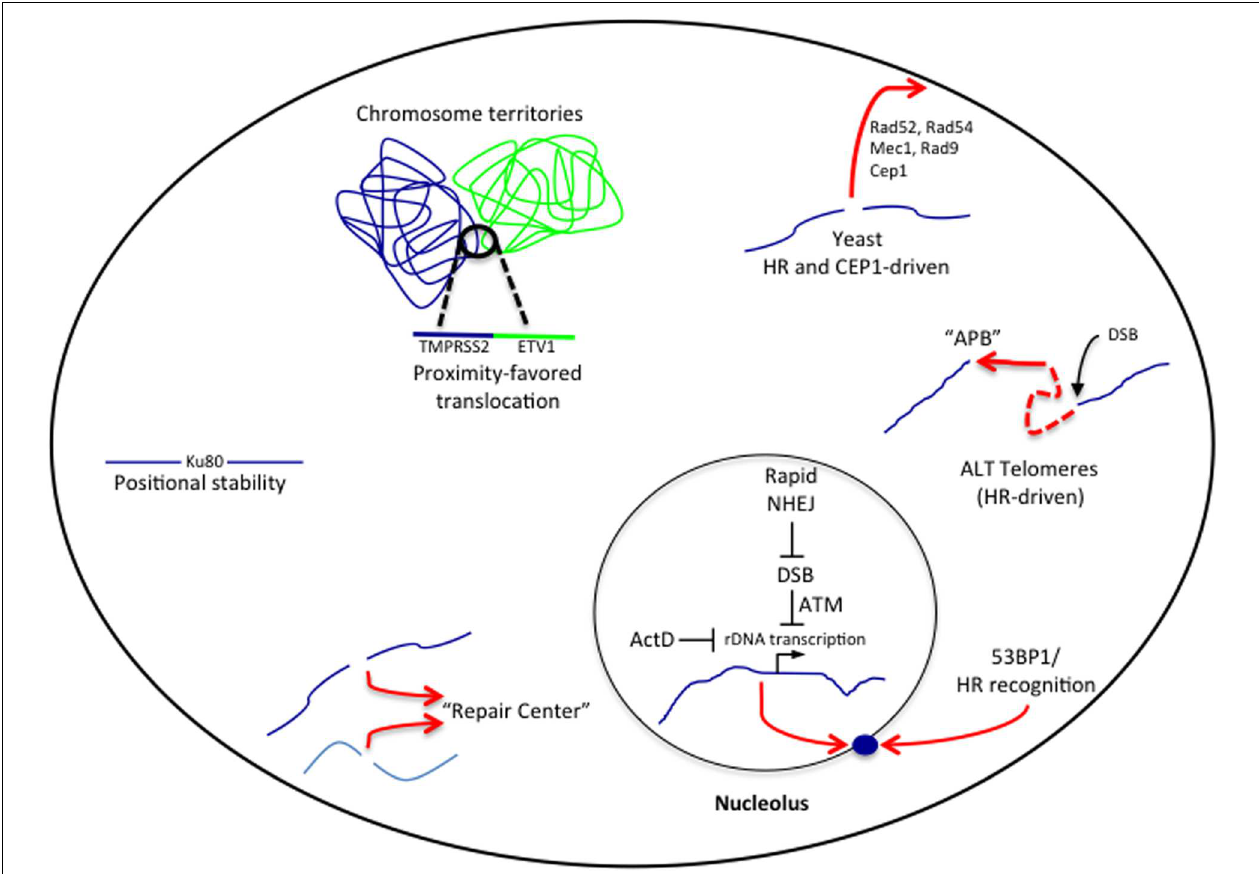
FIGURE 1 | Chromatin reorganization during double strand break (DSB) responses. In several contexts, DSBs induce chromatin reorganization. Errors in DSB repair can result in translocations that occur most frequently between chromosomes that are already in close spatial proximity through pre-existing organization into chromosome territories. Moving clockwise, persistent breaks in yeast are relocalized to the nuclear periphery in a SUMO dependent process for repair by homologous recombination (HR). Homology directed repair driven movement of DSBs induced at telomeres promotes clustering into ALT Promyelocytic Bodies (APBs). In nucleoli persistent breaks silence transcription, which leads to relocalization of the rDNA to the nucleolar periphery. In some instances multiple breaks appear to localize to “repair centers” while in other contexts breaks remain positionally